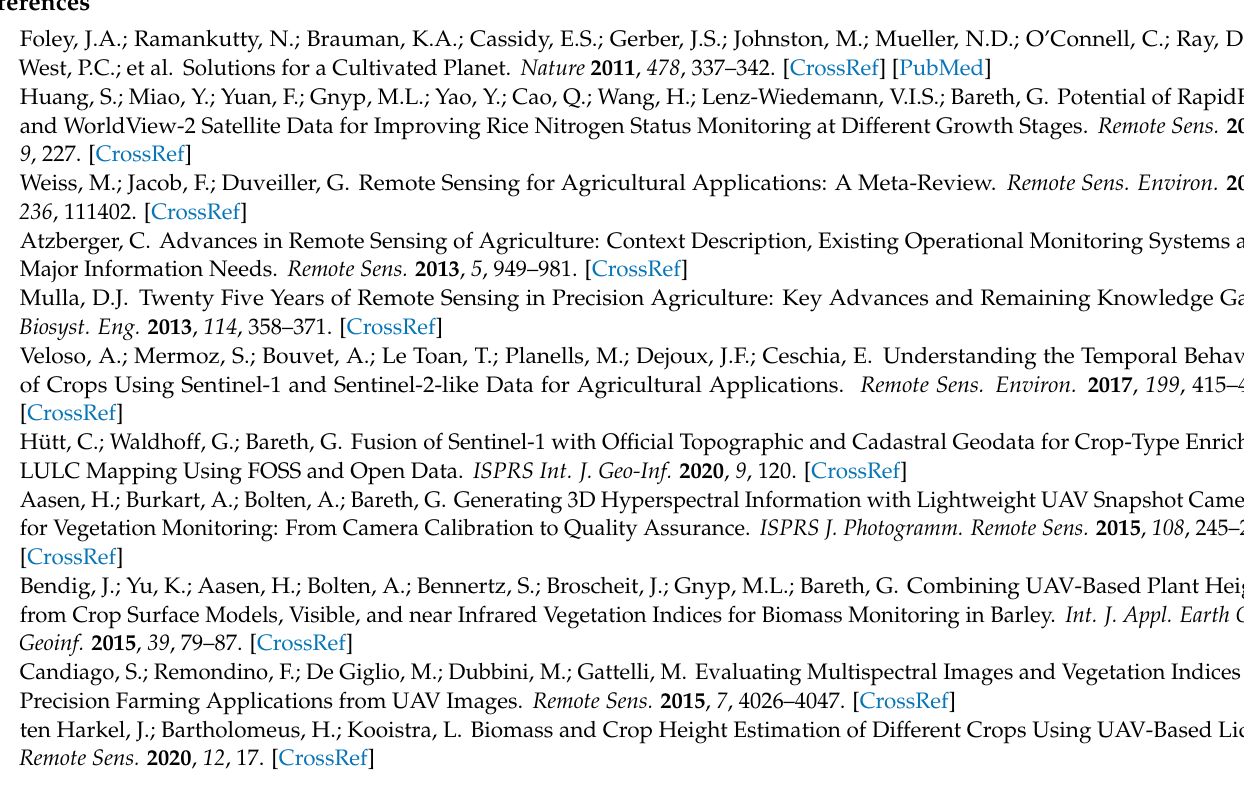
Figure A4. Regression analyses of the gray panel reflectance values in the WPM-calibrated images and the reflectance of the gray panels, measured by a portable ASD FieldSpec3 spectroradiometer (Malvern Panalytical Ltd, Malvern, United Kingdom) (ASD). For each of the four wavelength bands ( a – d ), five images were analyzed, and the resulting re- flectance of the respective gray panel was averaged. ( p < 0.001 for all regression